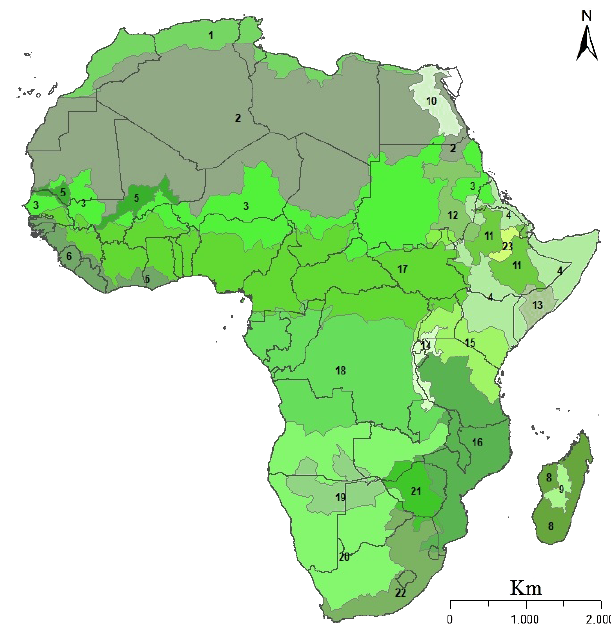
Figure 3. Delineation of the 23 irrigation cropping pattern zones in Africa (based on FAO, 1997; http://www.fao.org/geonetwork/srv/ en/main.home, last access: 1 April